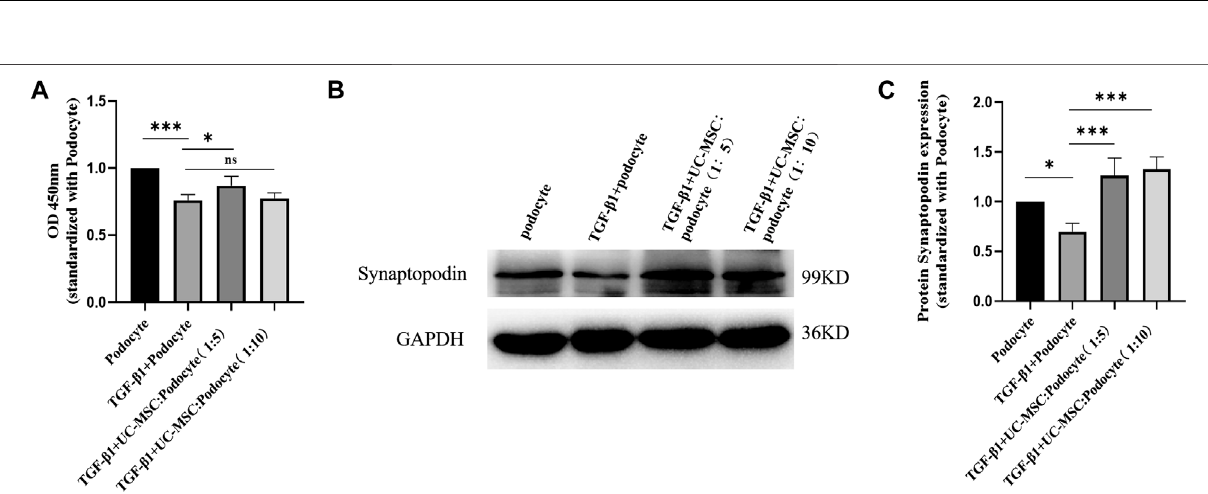
Frontiers in Cell and Developmental Biology |